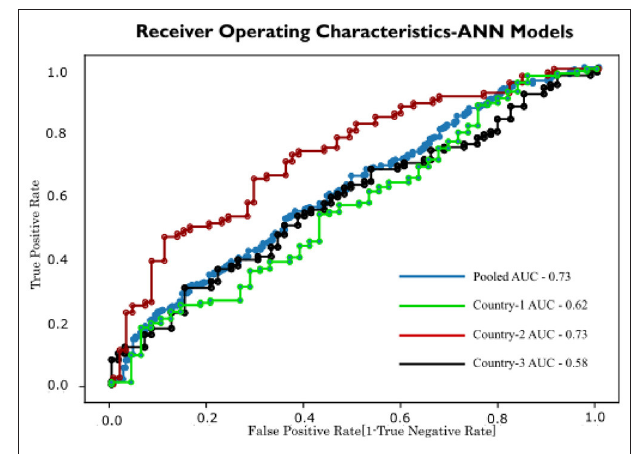
FIGURE 8 | ANN ROC